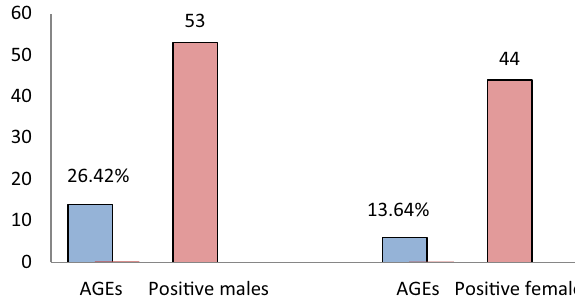
Figure 5. Distribution of AGEs by sex in SARS-CoV-2 positive